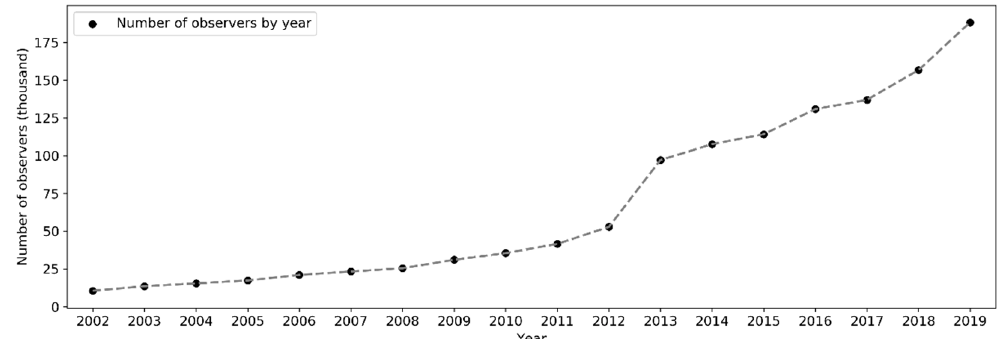
Figure 10. Number of active observers in each year (2002–2019). ISPRS Int. J. Geo-Inf. 2020 , 9 , x FOR PEER REVIEW